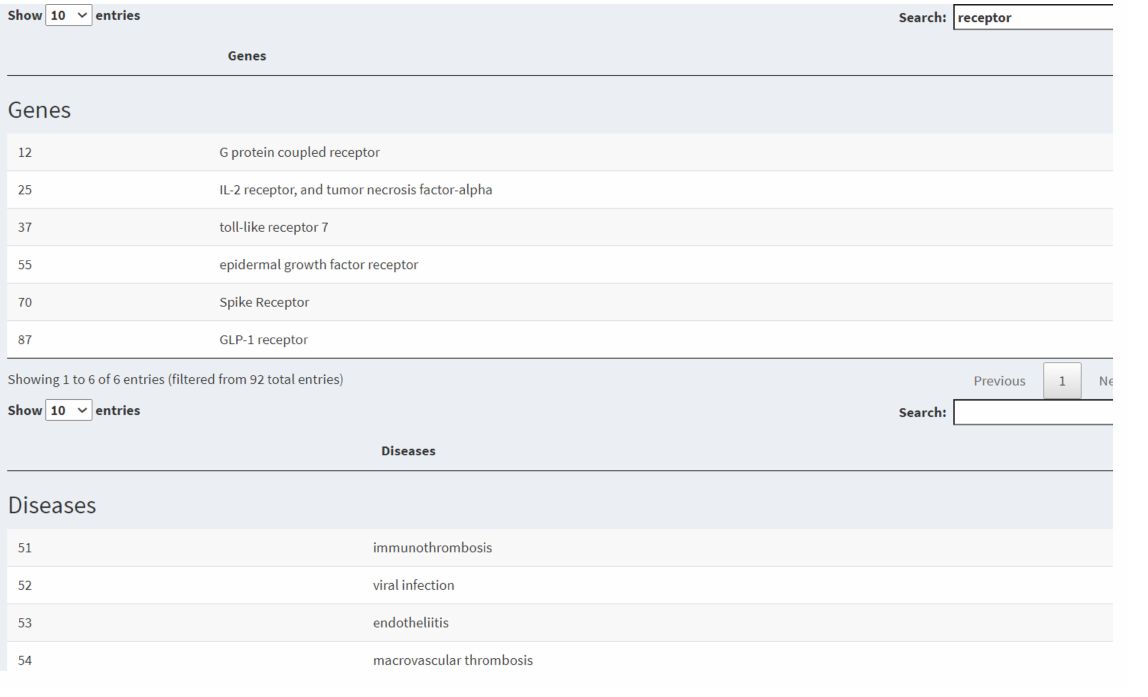
Figure 8. Tables of Genes and Diseases associated with specific gene search according to PubTator database. In the search box of the Genes and Disease tables, it is possible to locate specific terms, as can be seen with the “receptor” search in the first table of the